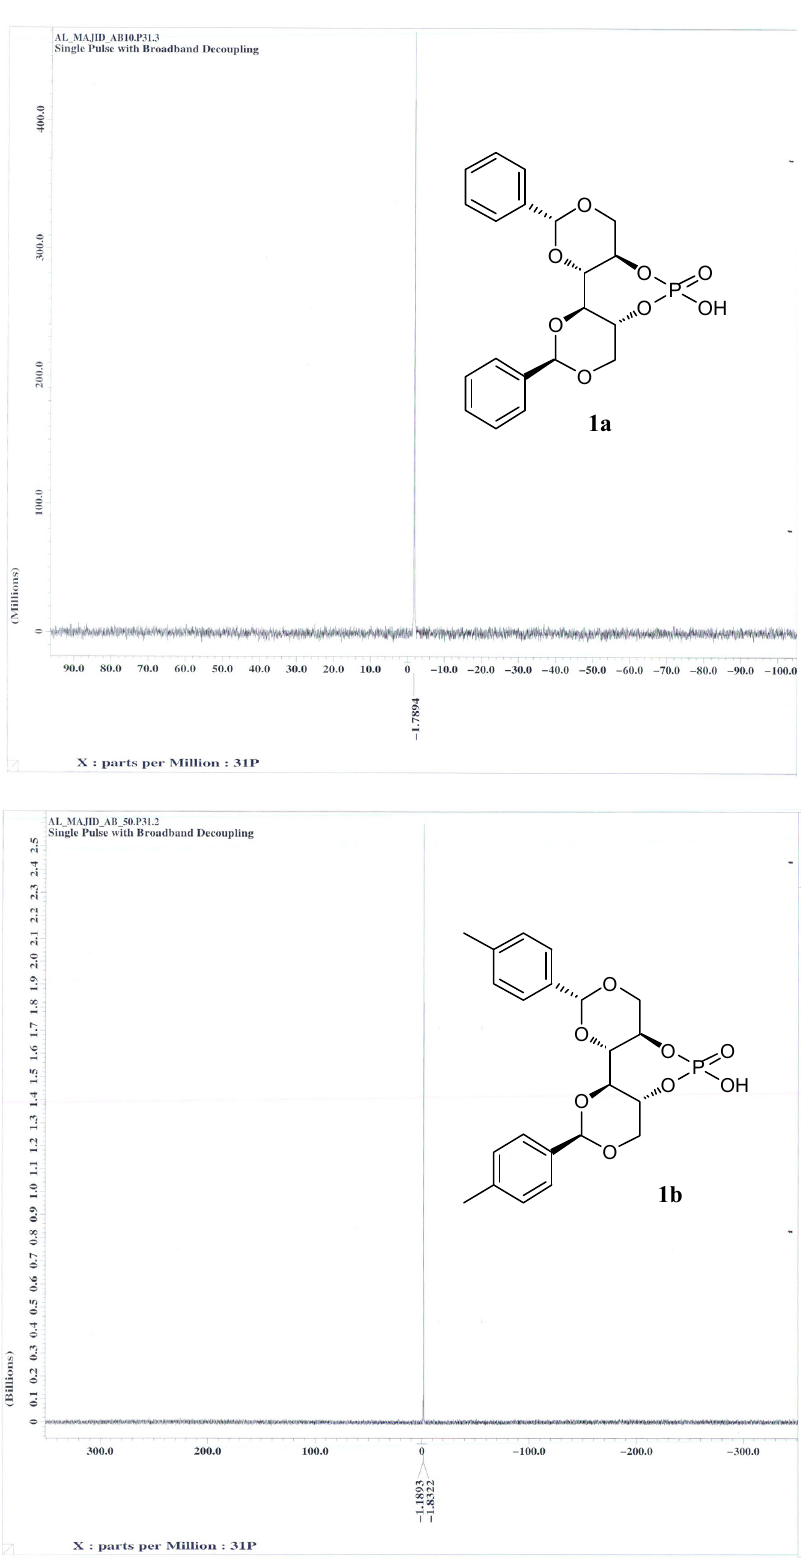
Figure 3. 31 P NMR data of the 1a,b